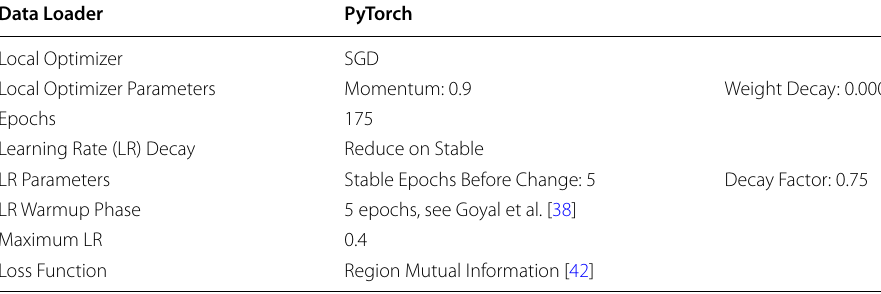
Table 3 Hyperparameters used to train the hierarchical multi-scale attention network using